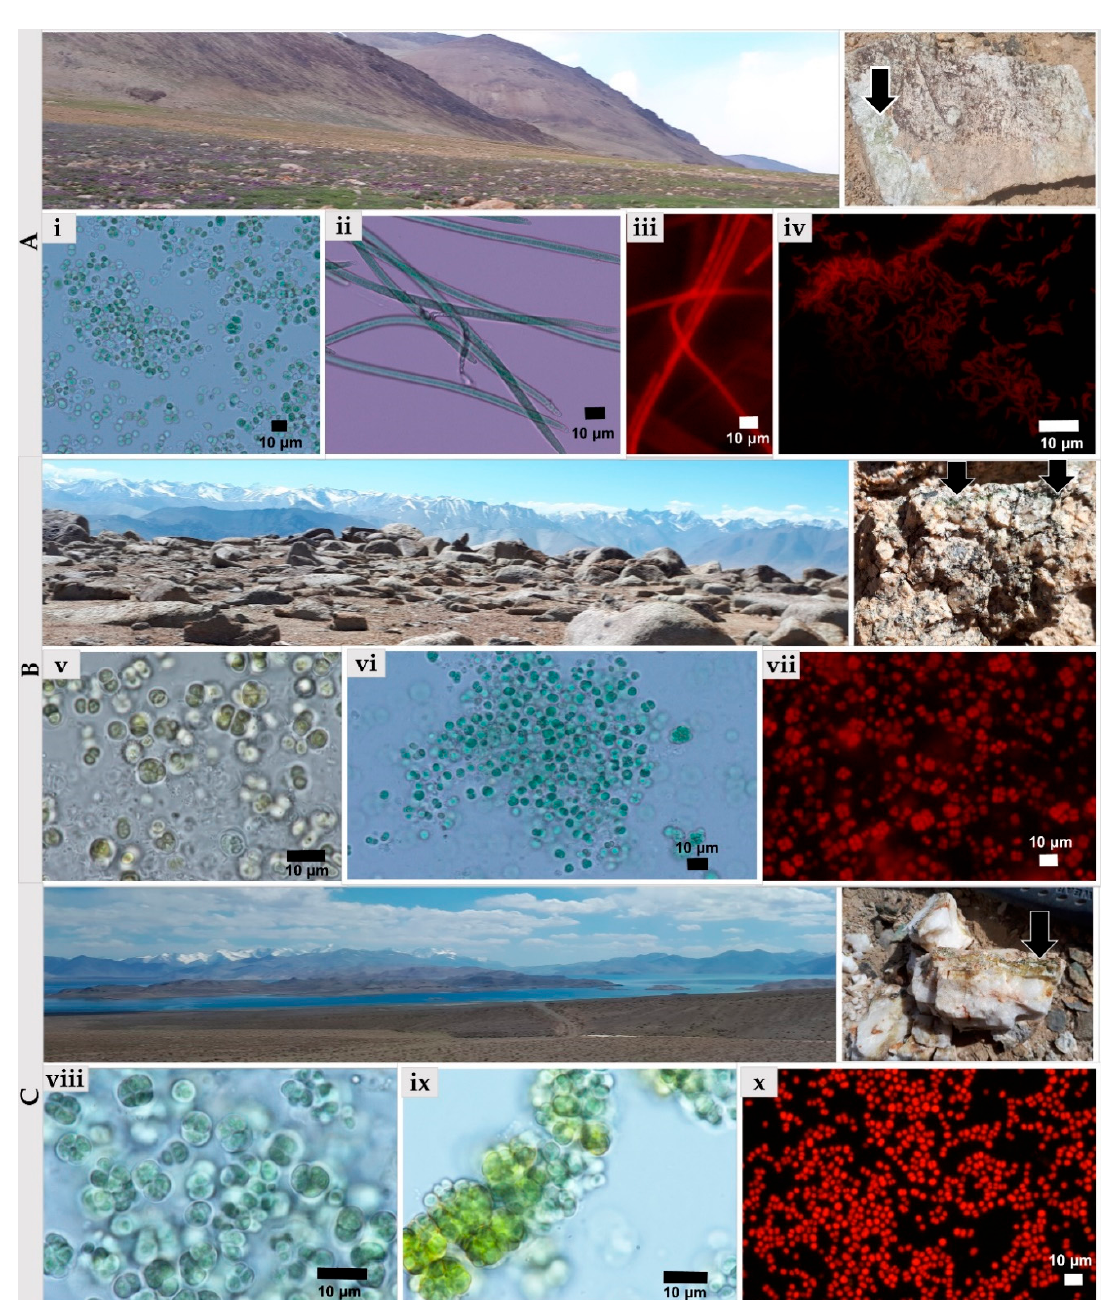
Figure 6. Isolates of endolithic cyanobacteria obtained from Pamirian granites and quartzites analyzed using light and epifluorescence microscopes. ( A ) Sampling sites and granitic rockfrom group A colonized by cyanobacteria (black arrow): ( i ) Chroococcidiopsis ‐ like cyanobacterium, ( ii ) and ( iii ) Microcoleus ‐ like morphotype, ( iv ) Synechococcus ‐ like cyanobacterium. ( B ) the sampling sites and the granite from group B colonized by cyanobacteria (black arrow): ( v ) Gloeocapsa ‐ like cyanobacterium, ( vi ) and ( vii ) Chroococcidiopsis ‐ like cyanobacterium. ( C ) sampling sites and granitic rock from group C colonized by cyanobacteria (black arrow): ( viii , x ) Chroococcidiopsis ‐ like cyanobacterium and ( ix ) Aliterella ‐ like cyanobacterium.